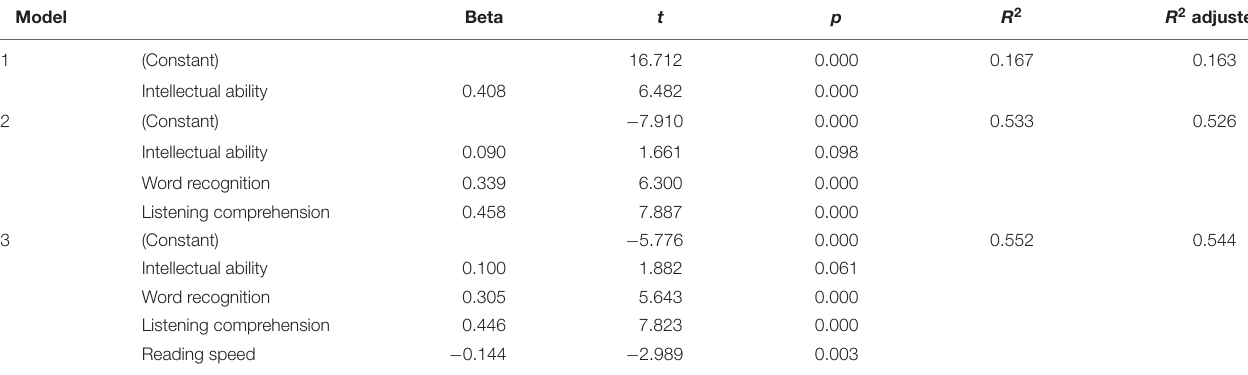
TABLE 3 | Models from the regression analysis of the prediction of reading comprehension. Model